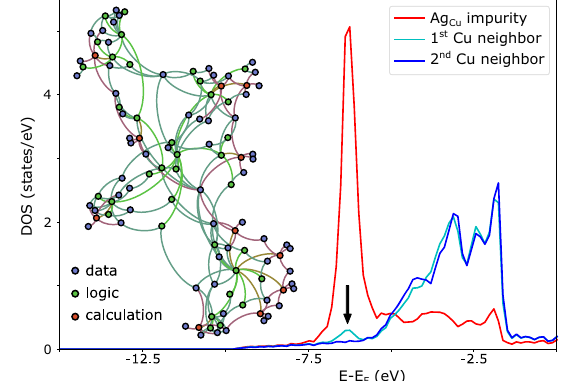
Fig. 5 Outcome of an impurity embedding calculation. Density of states of an Ag Cu impurity and its surrounding Cu neighbors. The black arrow highlights the hybridization-induced states in the fi rst Cu neighbor arising from the interaction with the d -resonance of the Ag defect. The inset (left) visualizes the database structure of the complete Ag Cu calculation which shows the complex relation between data nodes (structure input node, results Dict nodes etc.), logical nodes (e.g., different steps in kkr_scf_wc or kkr_imp_wc work fl ows) and calculations ( VoronoiCalculation , KkrCalculation and KkrimpCalculation